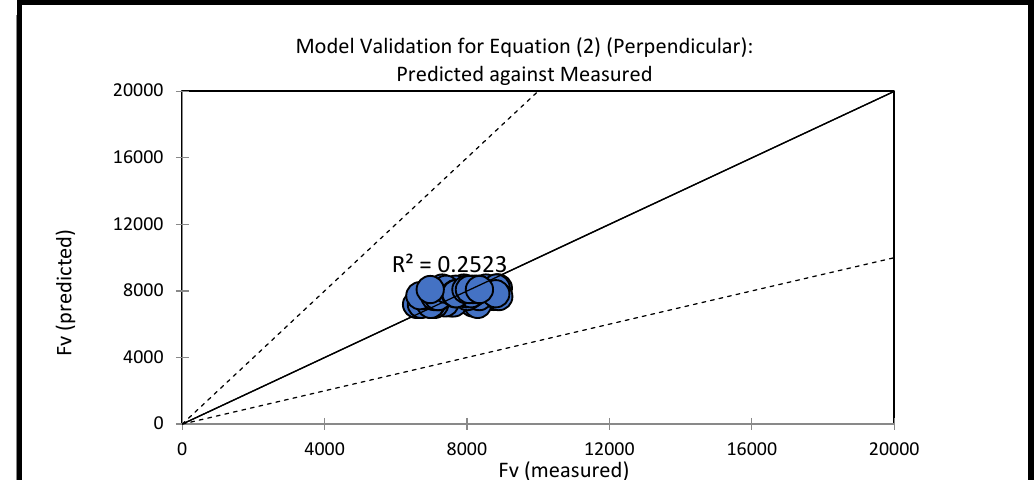
Figure 8. Model Validation for Equation (1) [ GRPS90 ◦ -1].